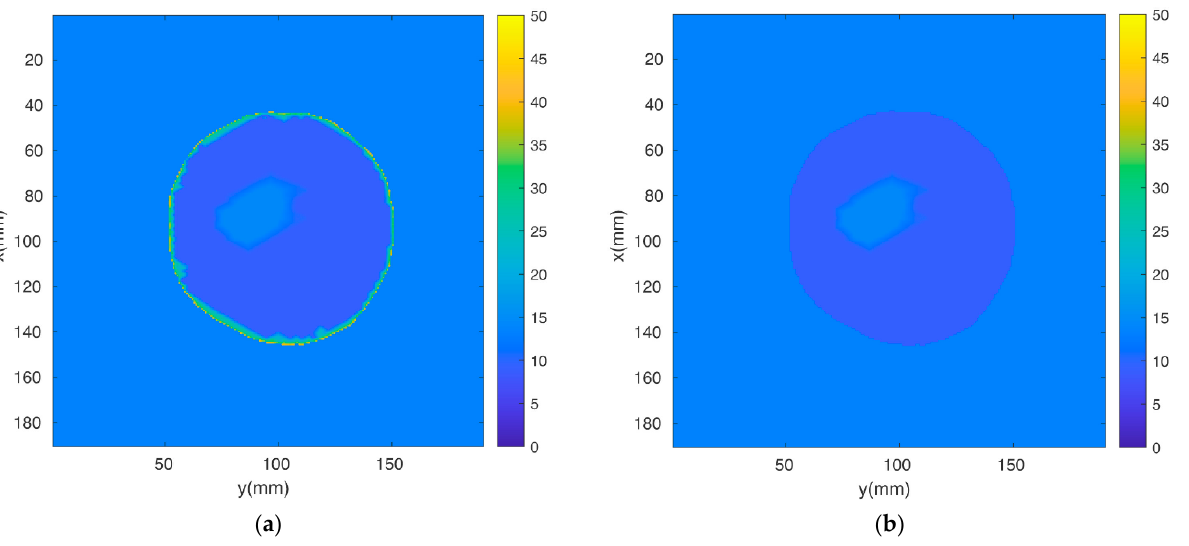
Figure 4. 3D finite element mesh generated from an MRI of an actual human breast suspended in a glycerin:water bath—blue for skin, green for adipose tissue, and red for fibroglandular tissue.